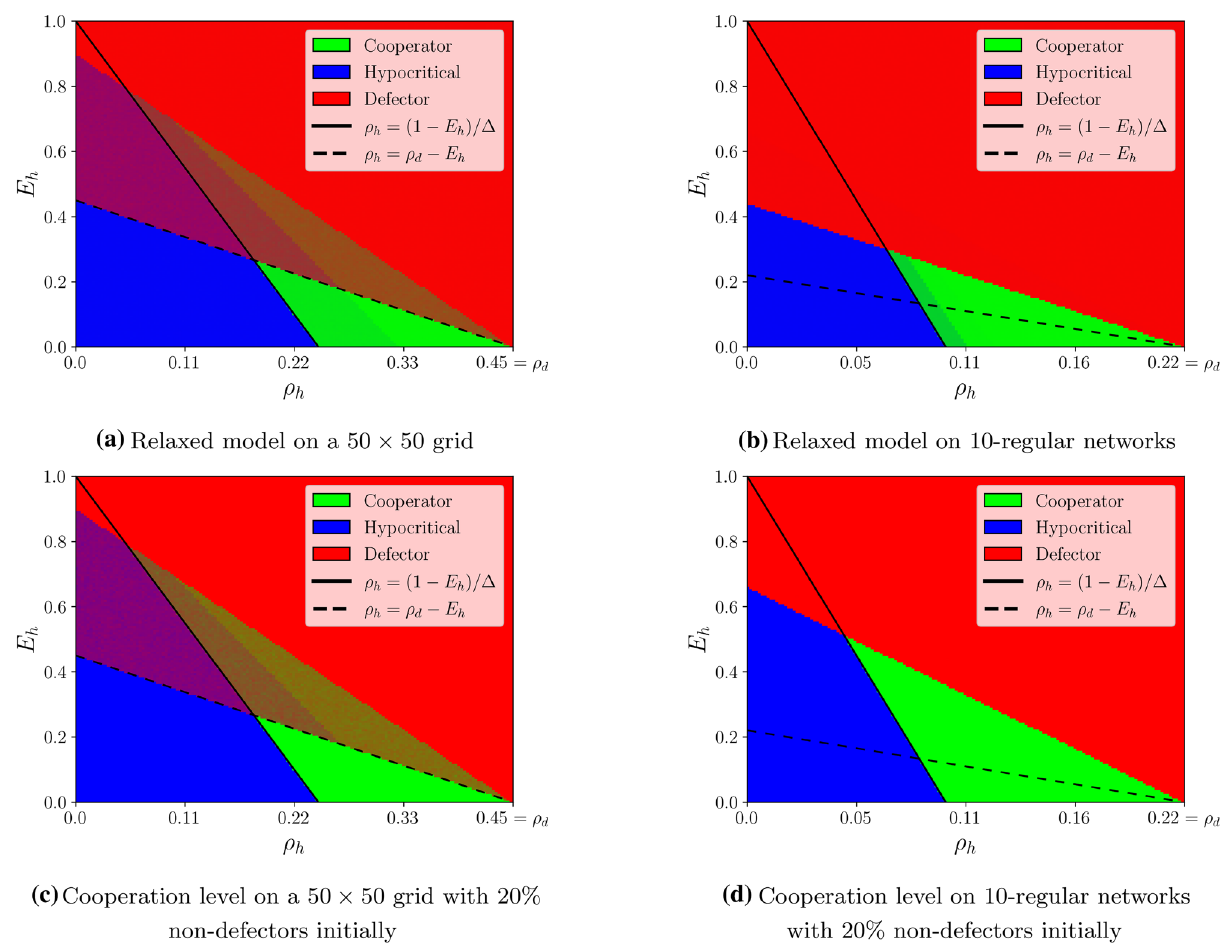
Figure 4. Relaxed model on grids and random 10-regular networks. The figure depicts simulation results using relaxed versions of the main model. In ( a ) and ( b ) the greediness assumption in the decision making process is relaxed, allowing for some “irrationality” (see “Methods” for more details). In ( c ) and ( d ), the initial configuration contains 80% defectors, instead of 99% as used in Fig. 3. The plots in ( a ) and ( c ) correspond to a 50 × 50 grid network and should be compared with Fig. 3a, whereas ( b ) and ( d ) correspond to random 10-regular networks with 1000 vertices and should be compared with Fig.